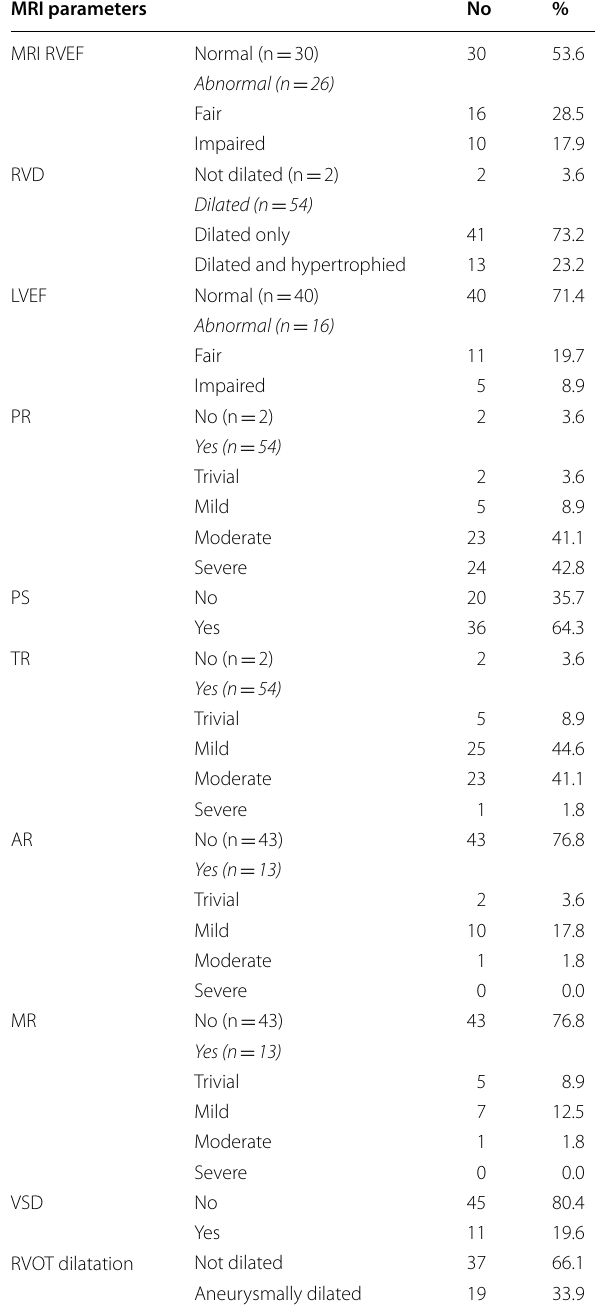
Table 5 Distribution of the studied 56 rTOF patients according to CMR